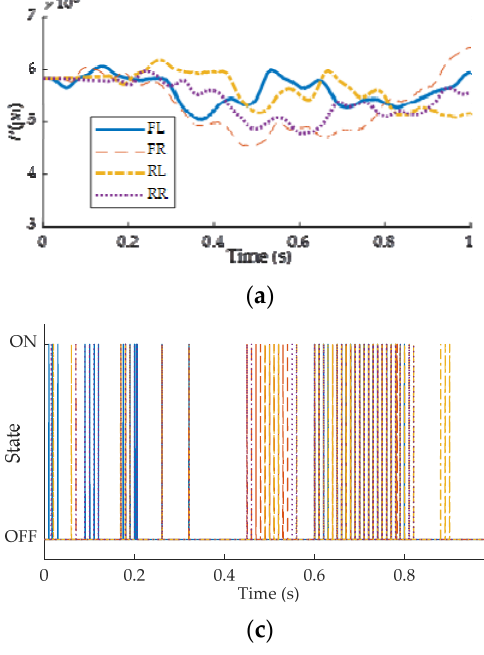
in Figure 6a, best suspension forces generated by interconnected mode activation are